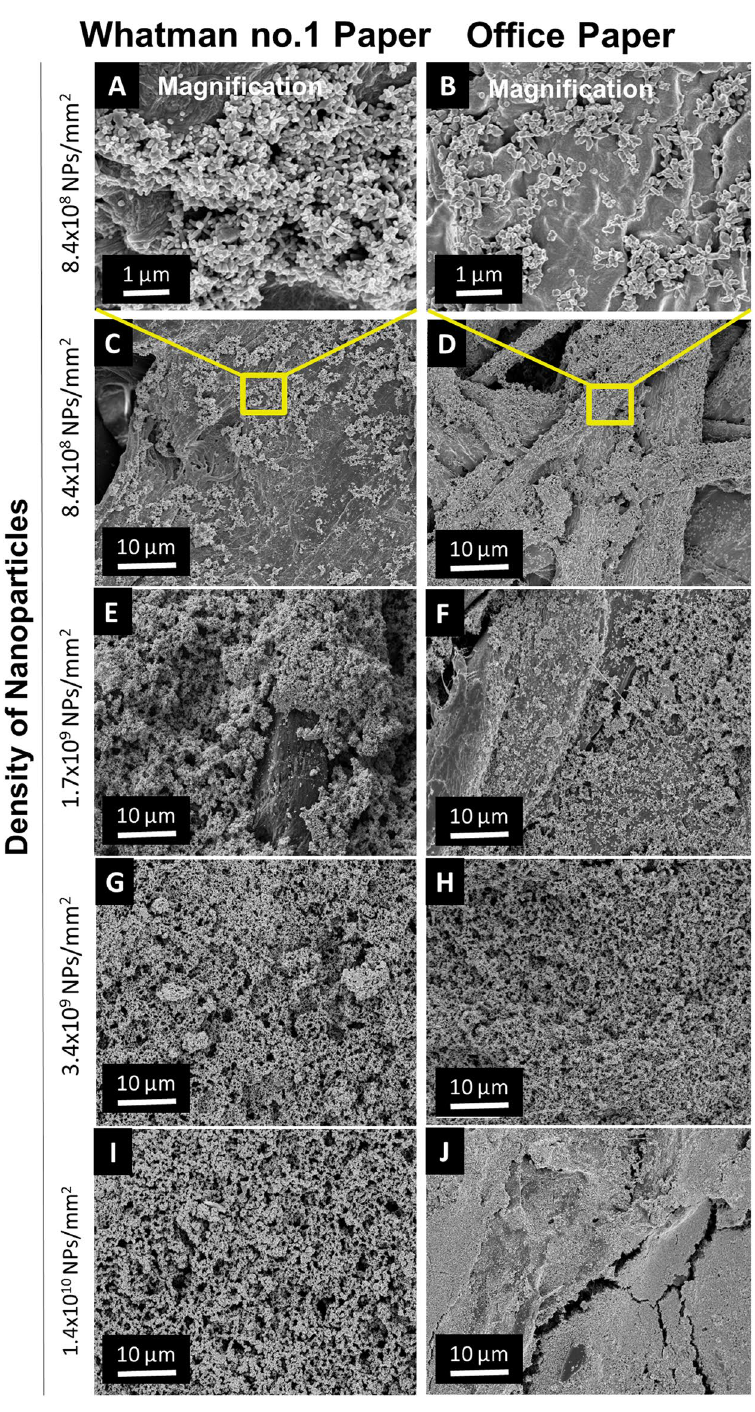
Figure 3. SEM micrographs of AgNSs in the two types of papers: Whatman no. 1 ( A,C,E,G , I ) and office paper ( B,D,F,H,J ). ( A and B ) are higher magnifications of ( C and D ), respectively with nanoparticle’s densities of 8.4 × 10 8 NPs/mm 2 showing the uniform distribution of AgNSs decorating the surface on Whatman no. 1 ( A ) and office ( B ) paper surfaces. From the top to the bottom of the figure, the amount of AgNSs added onto the paper well, increases from ( A , B ) and ( C , D ) 8.4 × 10 8 NPs/mm 2 ( E , F ) 1.7 × 10 9 NPs/mm 2 ( G , H ) 3.4 × 10 9 NPs/ mm; 2 ( I , J ) 1.4 × 10 10 NPs/mm 2